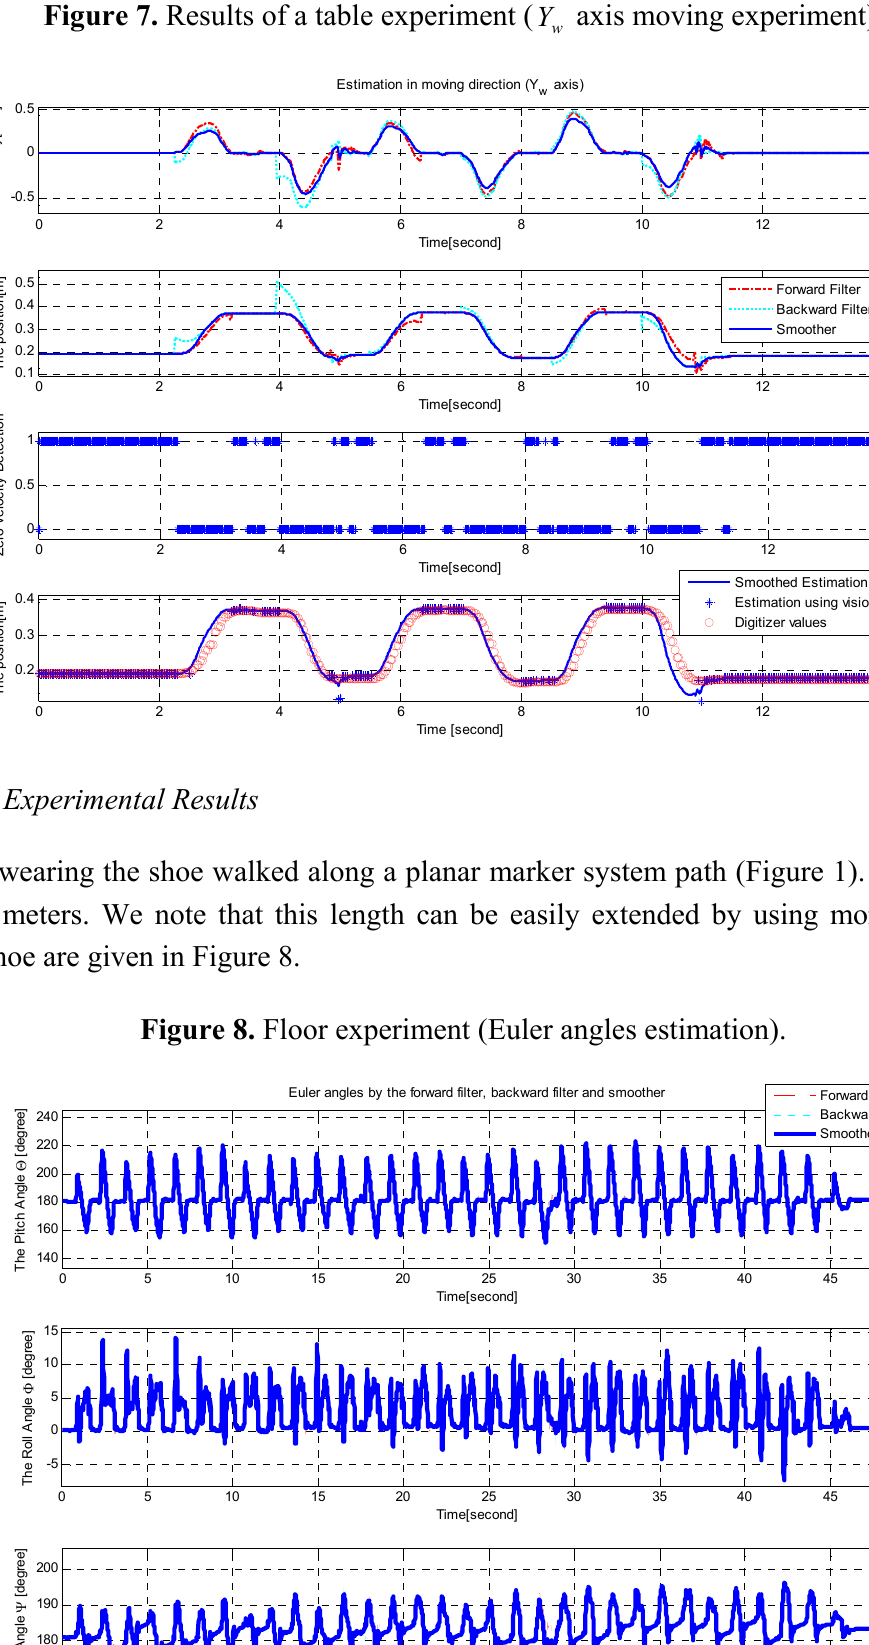
Figure 7. Results of a table experiment (